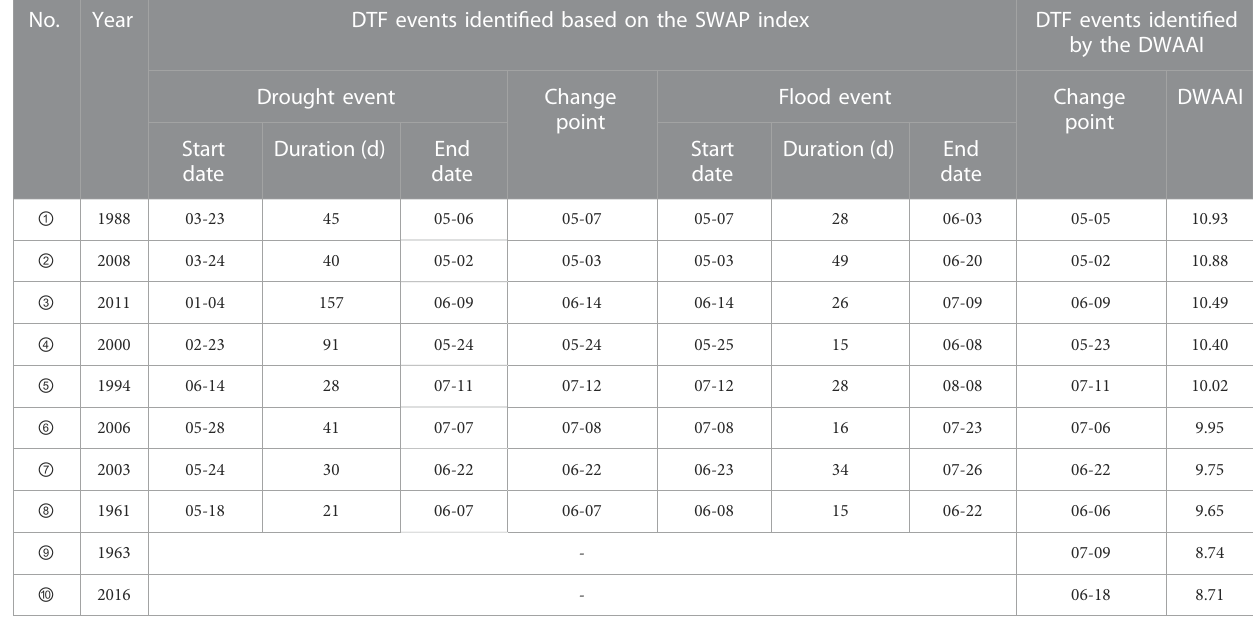
TABLE 3 Top ten DTF events identi fi ed by the DWAAI and their corresponding events identi fi ed based on the SWAP index at the Wuhan station. No. Year DTF events identi fi ed based on the SWAP